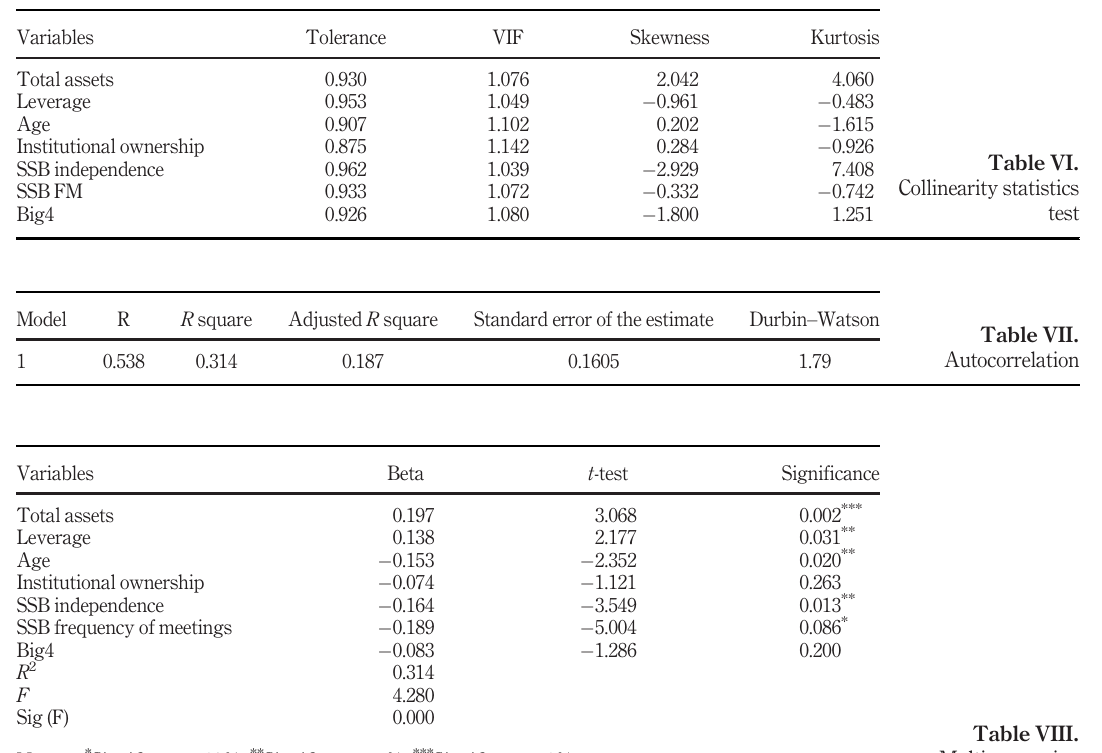
Table VIII. Multi